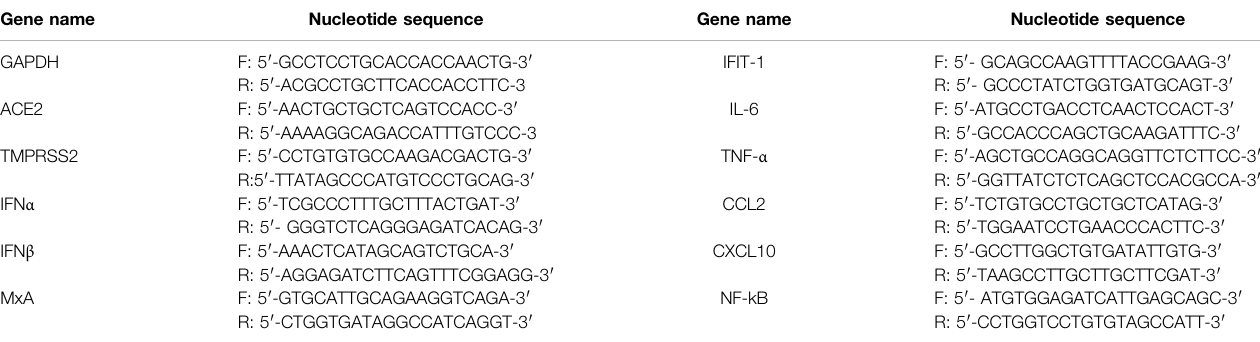
TABLE 3 | Primers used for real-time